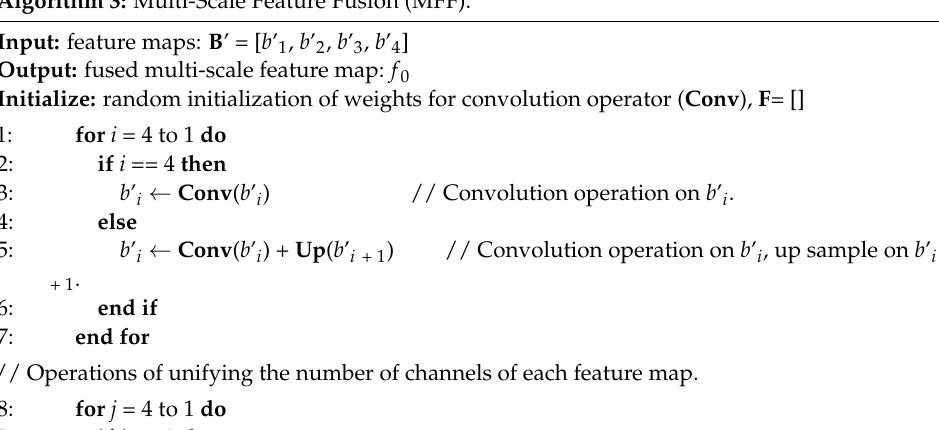
Algorithm 3: Multi-Scale Feature Fusion